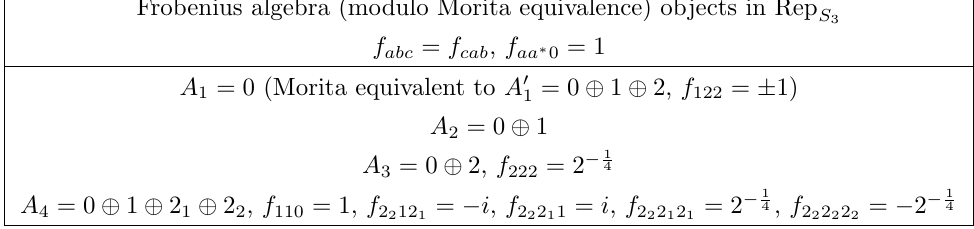
obtained by solving the de(cid:12)ning S 3 = 0 (cid:8) 1 (cid:8) 2 are Morita equivalent [12]. 1